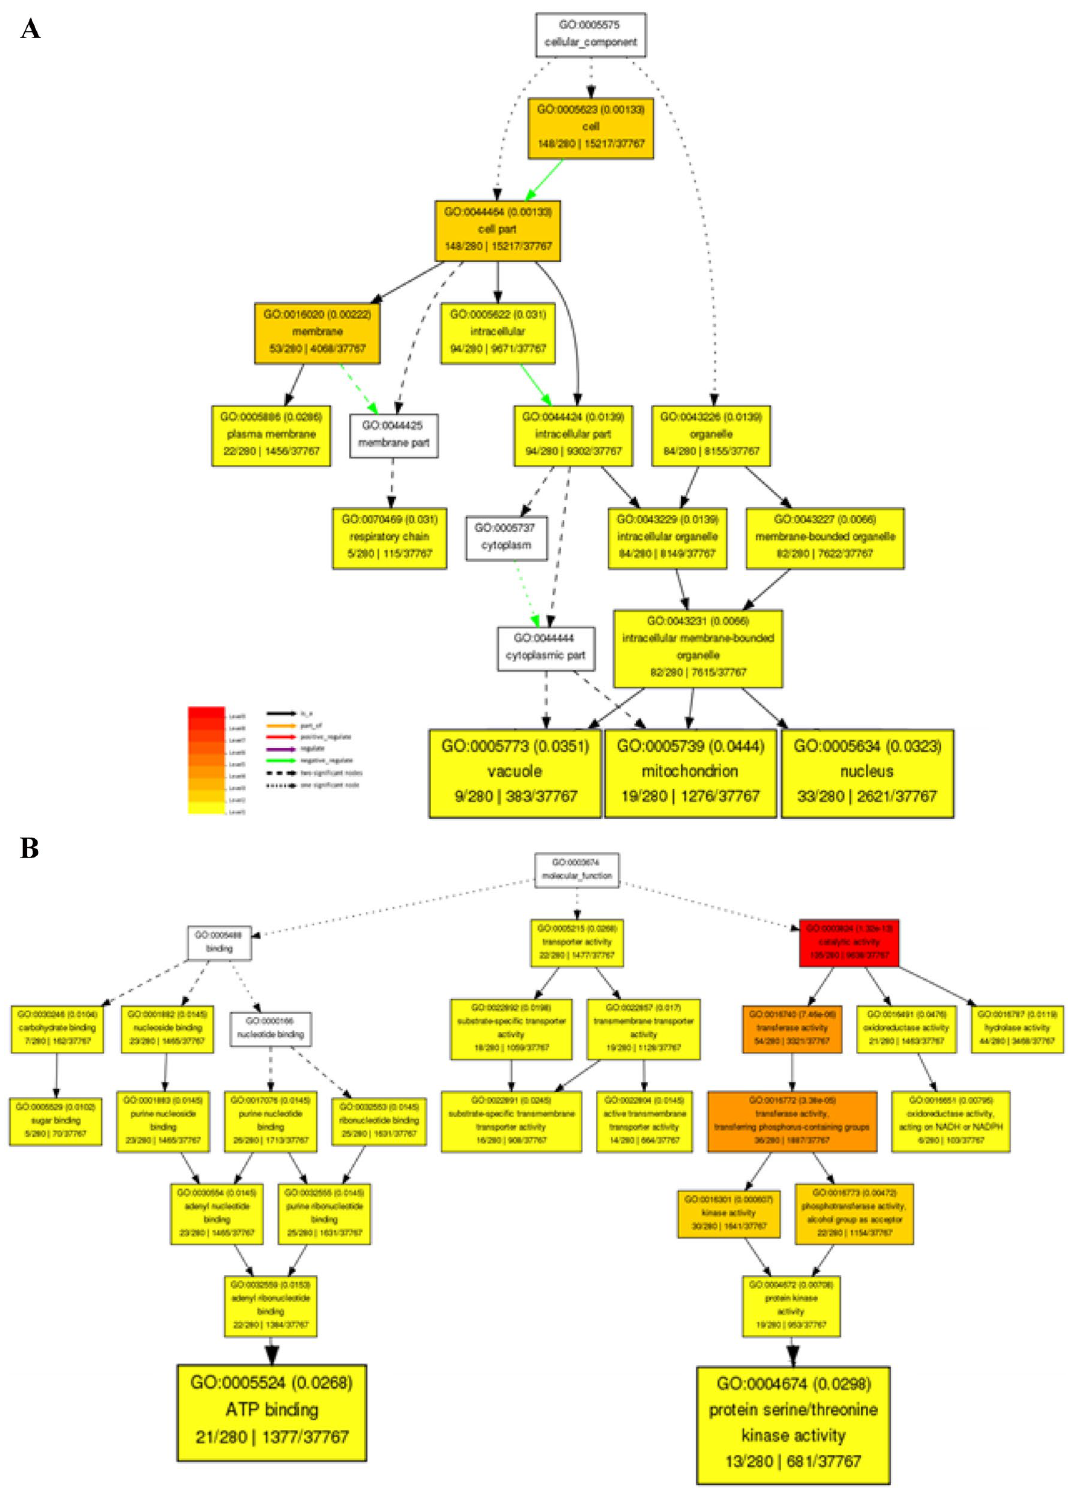
Figure 6. Potential functions of 525 salt responsive coding target genes of five selected miRNAs. ( A ) Cellular component and ( B ) Molecular function graphical results of coding target genes of selected miRNAs. Graphical results were prepared through the AgriGO v2.0 web-based tool (http:// syste msbio logy. cau. edu. cn/ agriG